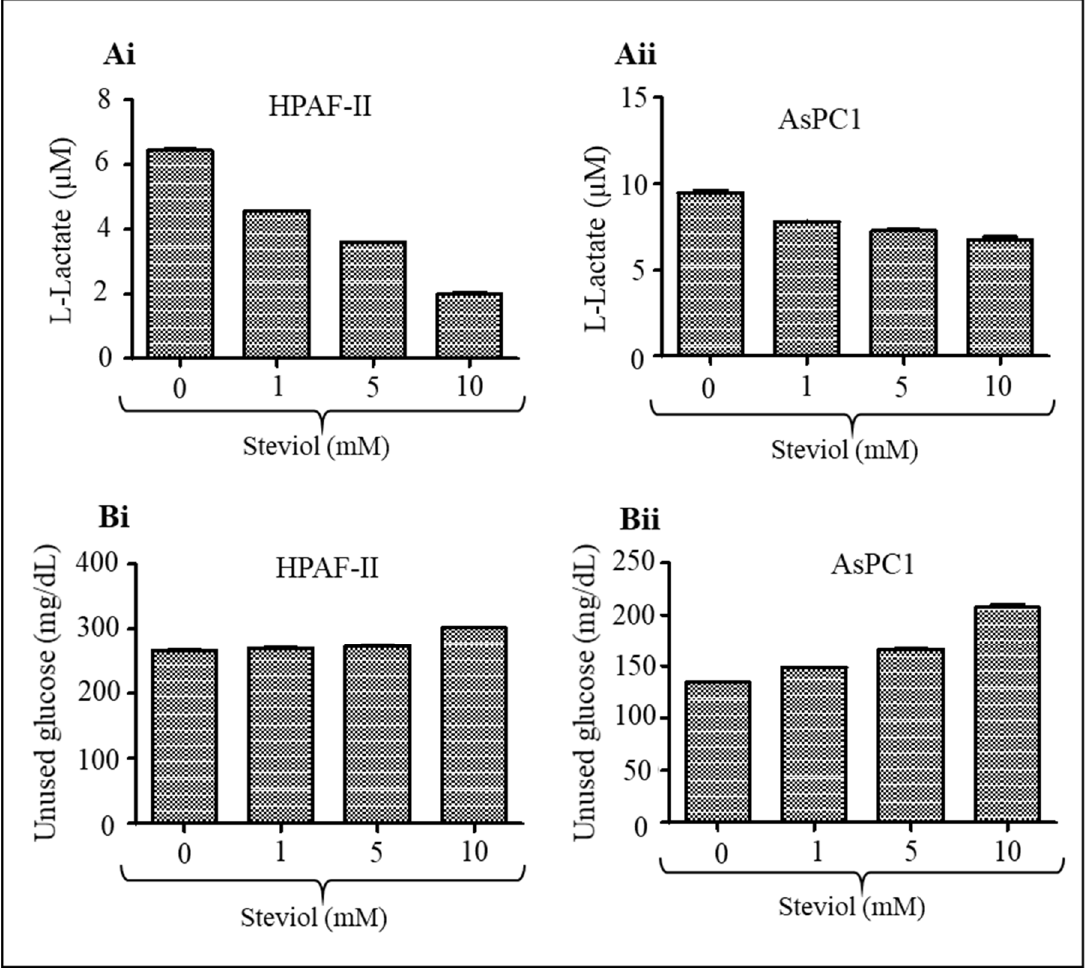
Figure 6. Steviol inhibits lactate secretion and glucose uptake in pancreatic cancer cells. ( A ) Effect of steviol on lactate secretion by pancreatic cancer cells as determined by glycolysis cell-based assay kit (Cayman Chemical, Ann Arbor, MI, USA). Bar graphs represent lactate secretion by HPAF-II ( Ai ) and AsPC1 ( Aii ) cells 24 h post-treatment of steviol. ( B ) Effect of steviol on glucose uptake by pancreatic cells as determined by glucose colorimetric assay kit after 48 hours of steviol treatment (Cayman Chemicals, Ann Arbor, MI, USA). Bar graphs represent the unused glucose in HPAF-II ( Bi ) and AsPC1 ( Bii ) cells. n = 2; * p <